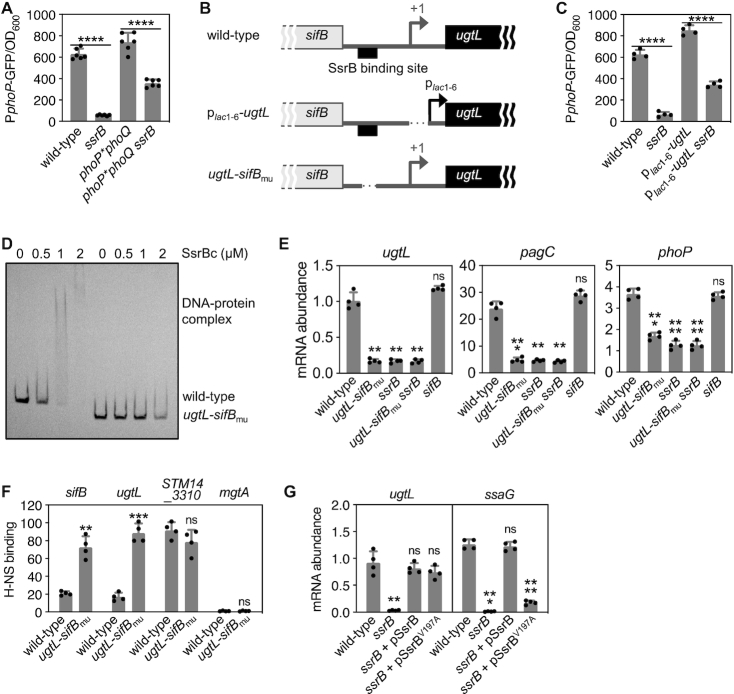
SsrB promotes UgtL expression, thereby enhancing PhoP activation in mildly acidic pH. (A, C) Fluorescence produced from a PphoP-gfp transcriptional fusion displayed by (A) wild-type (14028s), ssrB (EG14411), phoP*phoQ (EG10232), and phoP*phoQ ssrB (JC449) or (C) wild-type (14028s), ssrB (EG14411), plac1–6-ugtL (JC1360), plac1–6-ugtL ssrB (JC1449) S. Typhimurium. Bacteria were grown to mid-log phase in N-minimal media with 1 mM of Mg2+ at pH 4.9. (B) Schematics of the intergenic region between the ugtL and sifB genes in wild-type, plac1–6-ugtL and ugtL-sifBmuS. Typhimurium strains. (D) In vitro binding of SsrBc to the wild-type or mutant (mu) ugtL-sifB intergenic region DNA. Four nM of the ugtL-sifB intergenic region DNA (wild-type or mu) was incubated with purified SsrBc (0, 0.5, 1 and 2 μM) proteins. A representative of at least three independent experiments is shown. (E) mRNA abundance of the ugtL, pagC and phoP genes produced by wild-type (14028s), ugtL-sifBmu (JC1547), sifB (JC1567), ugtL-sifBmussrB (JC1548), and ssrB (EG14411) S. Typhimurium grown to mid-log phase in N-minimal media with 1 mM of Mg2+ at pH 4.9. (F) In vivo binding of H-NS to the promoter regions of the sifB, ugtL, STM14_3310 and mgtA genes were determined in hns-FLAG (JC805) and hns-FLAG ugtL-sifBmu (JC1625) S. Typhimurium strains grown to mid-log phase in N-minimal media with 1 mM of Mg2+ at pH 4.9 using chromatin immunoprecipitation. (G) mRNA abundance of the ugtL and ssaG genes produced by wild-type (14028s) and ssrB (EG14411) S. Typhimurium with plasmids expressing wild-type SsrB or its variant (V197A) grown to mid-log phase in N-minimal media with 1 mM of Mg2+ at pH 4.9 (acidic pH) supplemented with 5 μM IPTG. The mean and SD from at least four independent experiments are shown (A, n = 6; C, E–G, n = 4). Each dot represents individual biological sample (A, C, E–G). Two-tailed t-test with (A and C) ssrB+ versusssrB− or (F) wild-type versus ugtL-sifBmu. One-way ANOVA with Brown-Forsythe and Welch tests (wild-type versus others) (E and G); ns, not significant; **P < 0.01, ***P < 0.001, ****P < 0.0001.